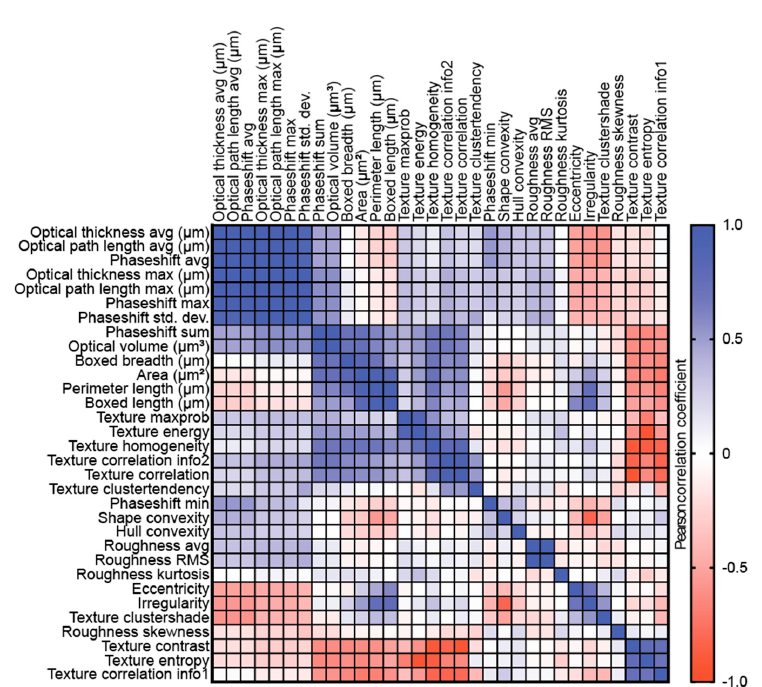
Figure 4. Matrix demonstrating correlation coefficients between DHC-derived cellular features.